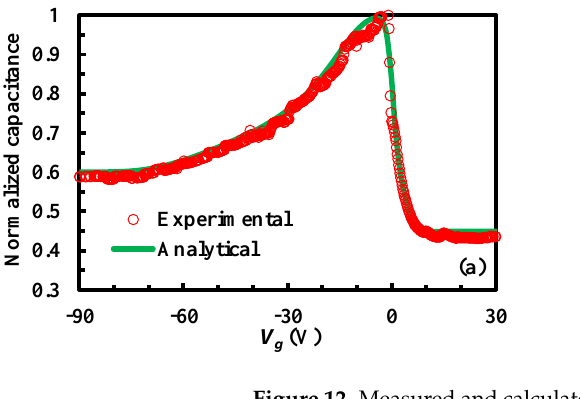
Figure 12. Measured and calculated high-frequency capacitance versus applied voltage of the stacked bonding structure: ( a ) sample A; ( b ) sample B.